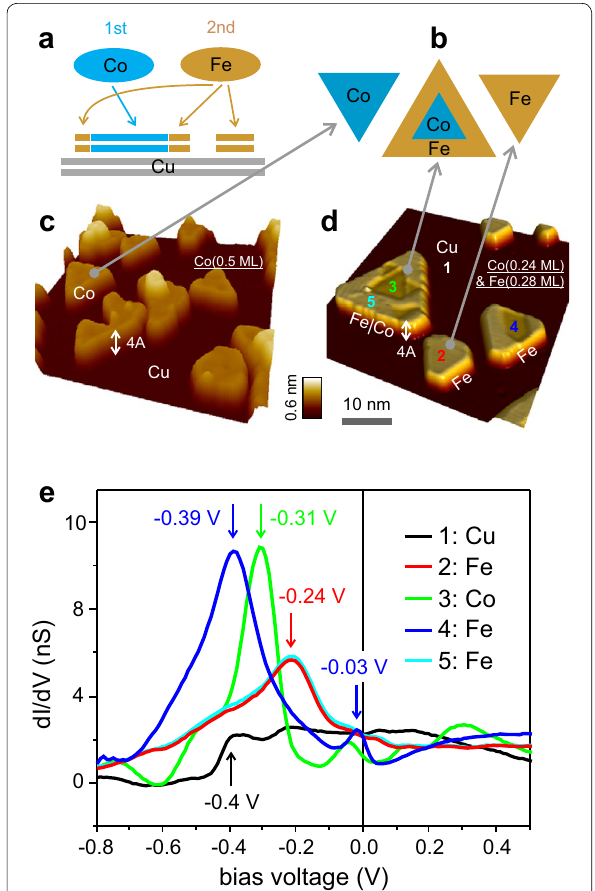
Fig. 2 Preparation of biatomic‑layer‑high Co and Fe nanoislands on Cu(111). a An illustration showing the sample preparation. A submonolayer (sub‑ML) of Co was deposited first on the Cu(111) substrate. Then a sub‑ML of Fe was deposited subsequently. b CC‑ STM image of the sample surface after Co deposition of an amount equivalent to 0.5 ML. (50 50 nm 2 ; V b 0.1 V; I set 2 nA). c STM × = = image of the sample surface after 0.24 ML Co deposition followed